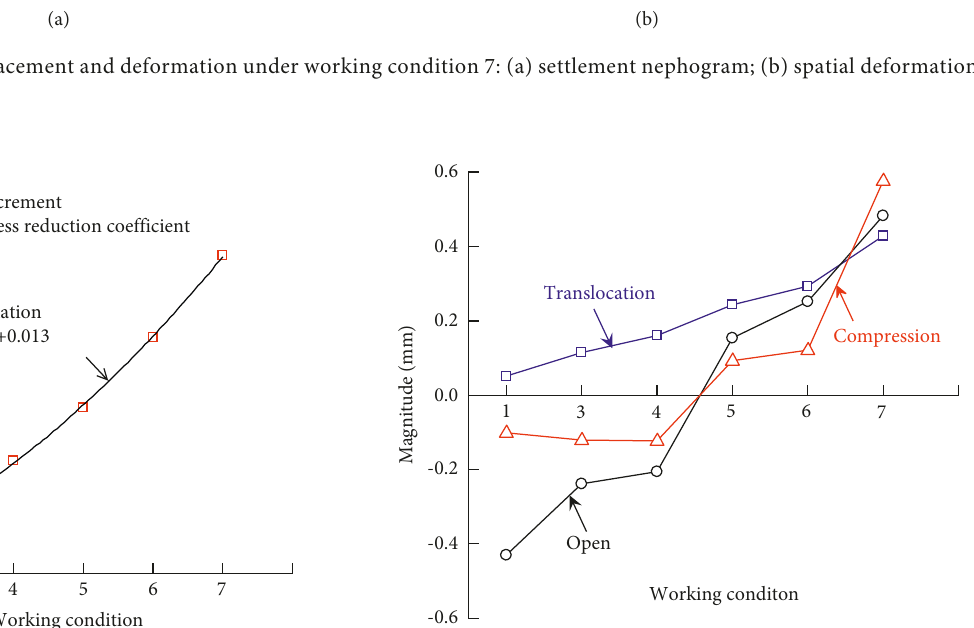
Figure 13: The settlement increment under different working conditions.